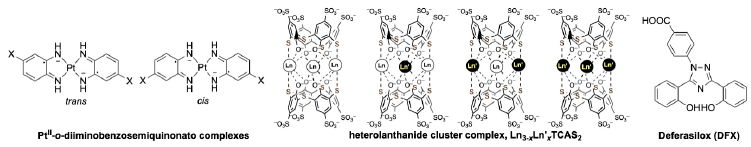
Figure 2. Structures of metal Figure 1. Structures of metal complexes.